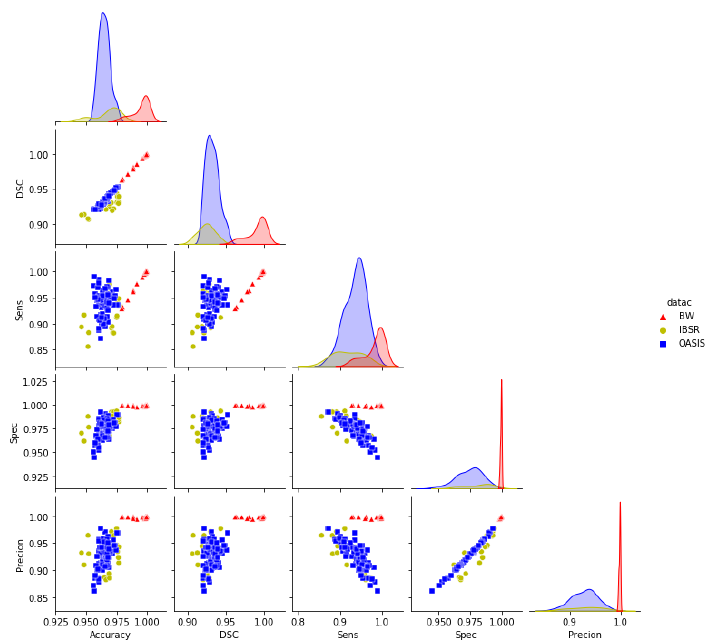
Figure 11. Pair plots for the measures of similarity (Combined data sets): Pair plots showing the pairwise relationship between different measures of similarity for the results obtained using GUBS across the combined data sets. DSC = Dice Similarity coefficients, Sens = Sensitivity, Spec =